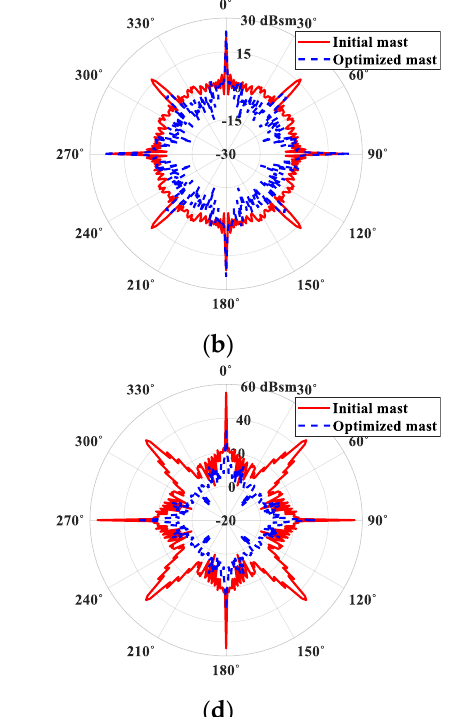
Figure 5. Three-dimensional RCS pattern of the optimized mast. ( a ) HH polarization in the L-band, ( b ) VV polarization in the L-band, ( c ) HH polarization in the S-band, ( d ) VV polarization in the S-band, ( e ) HH polarization in the X-band, ( f ) VV polarization in the X-band. (Unit: dBsm).